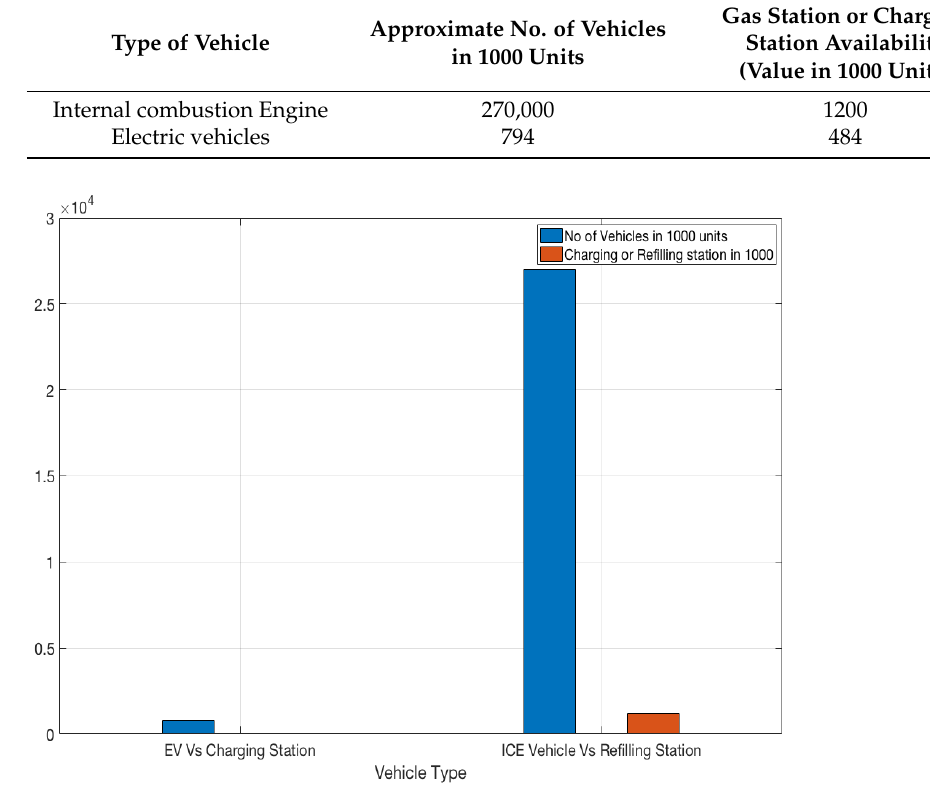
Figure 10. Comparison of internal combustion engines and refueling stations with electric vehicles and charging stations.